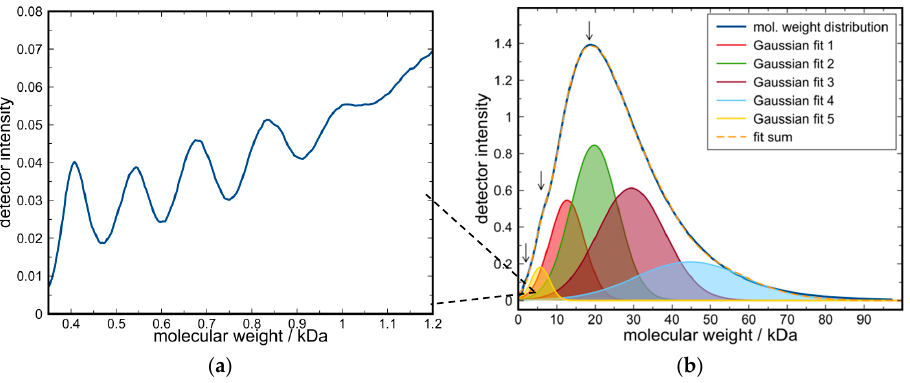
Figure 5. SEC trace for the polymerization of ε -CL with Novozym ® 435 in toluene showing ( a ) the oligomeric fraction; and ( b ) the high molecular weight fraction including the deconvolution of the original chromatogram by Gaussian fits.